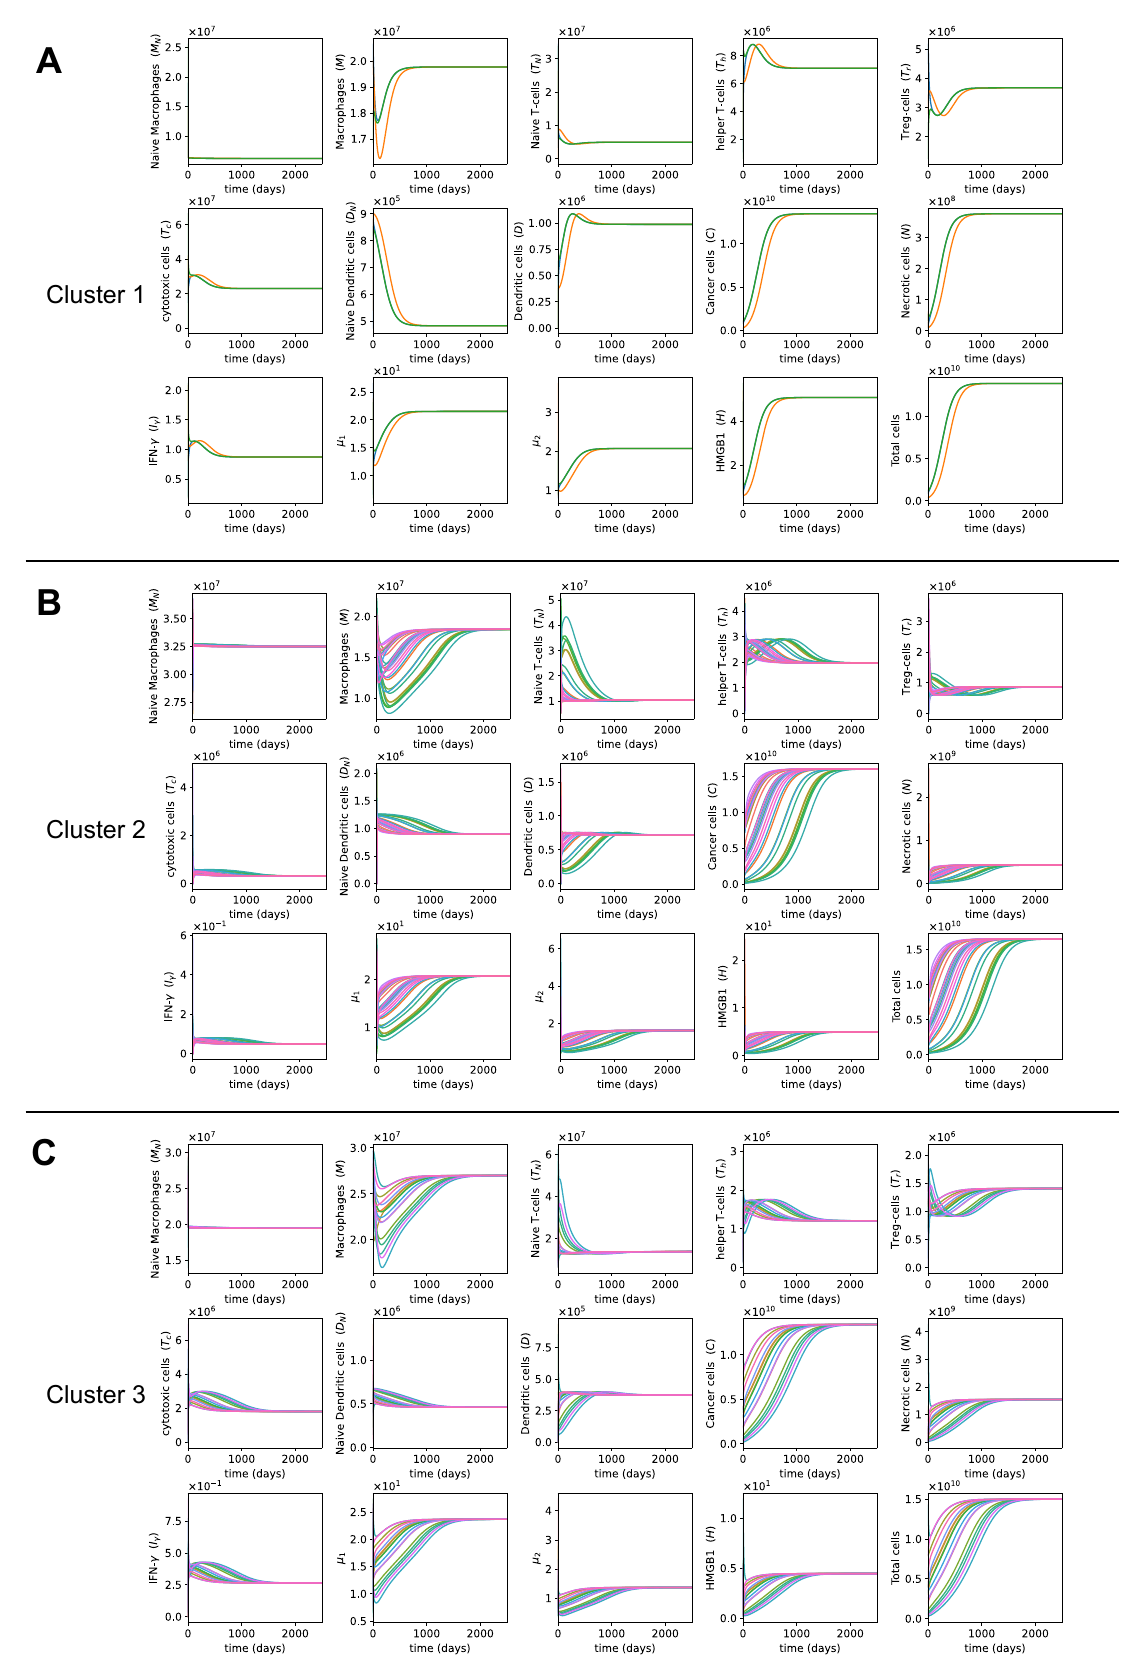
Figure 7. The dynamics with varying initial conditions. ( A – C ) The dynamics of cells and cytokines with initial conditions from different patients in clusters 1, 2, and 3,